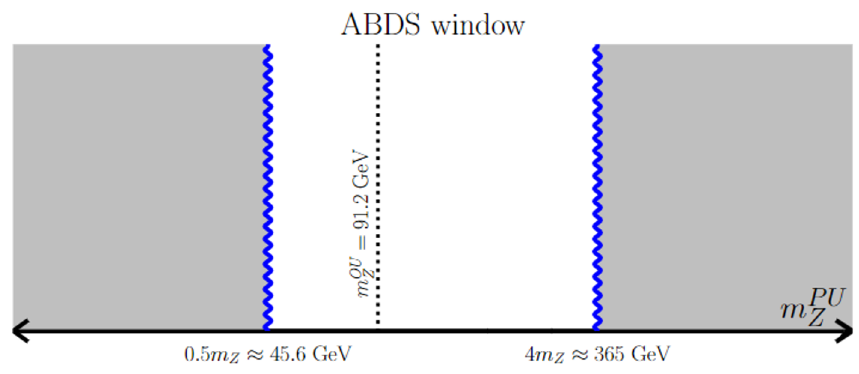
Figure 2. The ABDS-allowed window within the range of m PU